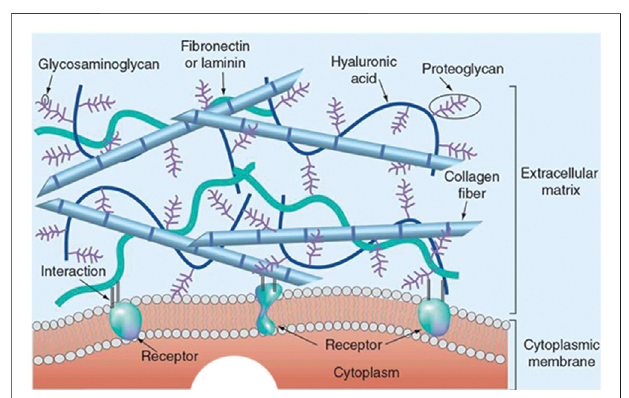
FIGURE 3 | The 3D structure model of the natural ECM. Reprinted with permission from (Aghmiuni and Khiavi,